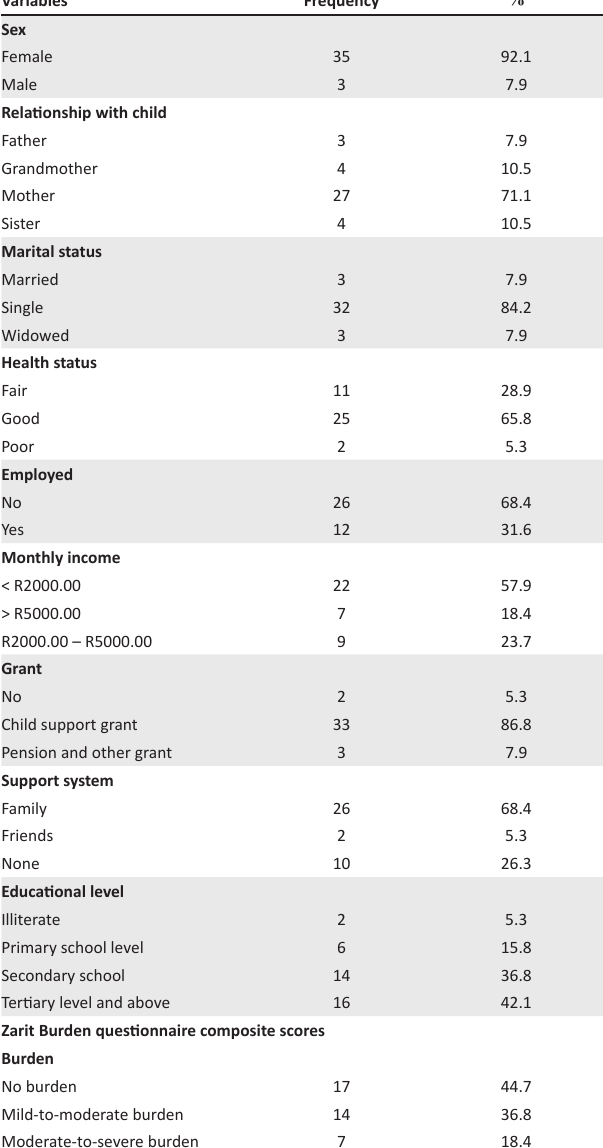
TABLE 2: Relationship of variables with severity of burden of care. Variables